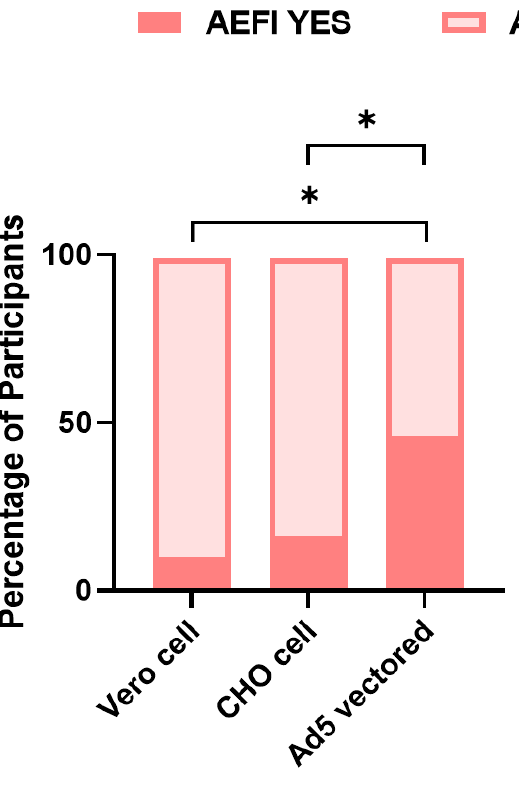
Figure 1. Statistical analysis performed using the χ 2 test to compare the frequency of AEFI between 3 groups of vaccines. * p -value < 0.05 ( p -value was adjusted by Bonferroni).